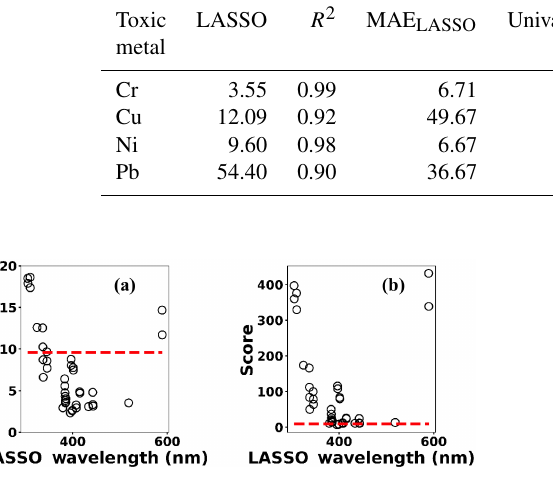
Figure 12. (a) The univariate LODs based on LASSO selected fea- tures and (b) LASSO and univariate models scores.